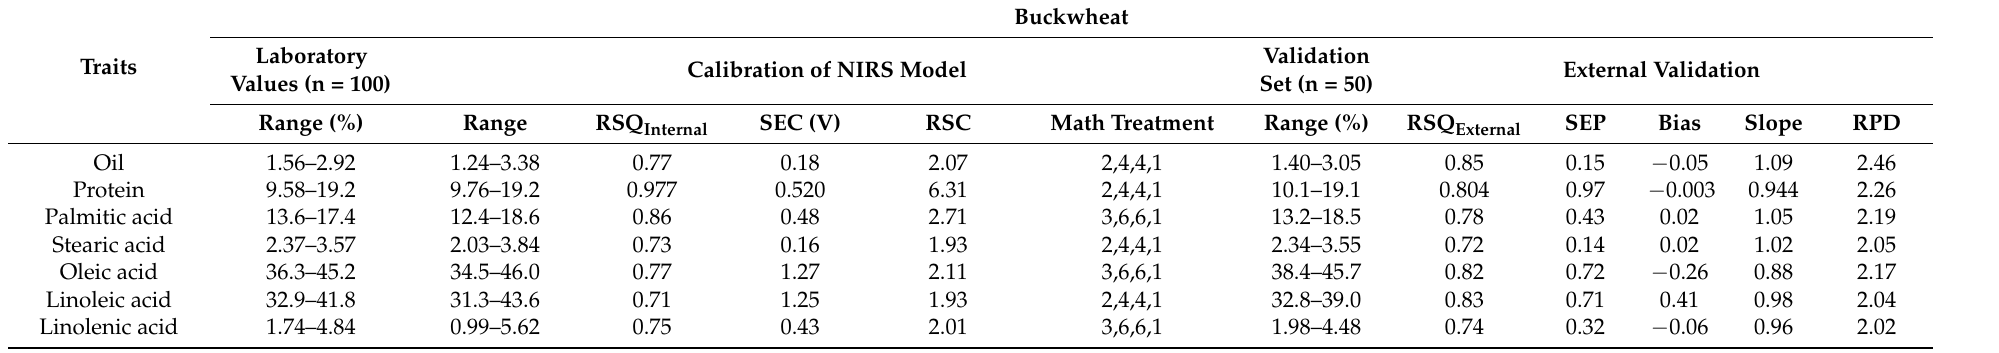
Table 2. Statistics for different traits of buckwheat used in calibration and